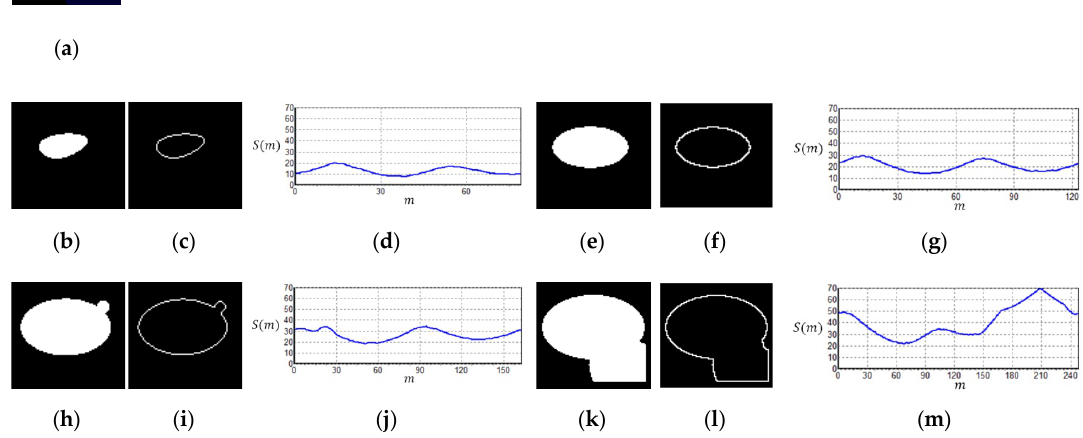
Figure 5. Signature of the color layer regions ( S ( m ) ): ( a ) four regions based on color quantization image; ( b ) Q1; ( c ) contour of Q1; ( d ) signature of Q1; ( e ) Q2; ( f ) contour of Q2; ( g ) signature of Q2; ( h ) Q3; ( i ) contour of Q3; ( j ) signature of Q3; ( k ) Q4; ( l ) contour of Q4; ( m ) signature of Q4.